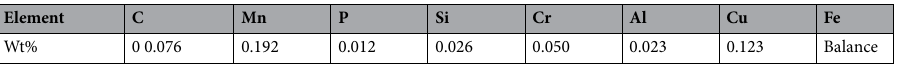
Table 1. Chemical composition of mild steel